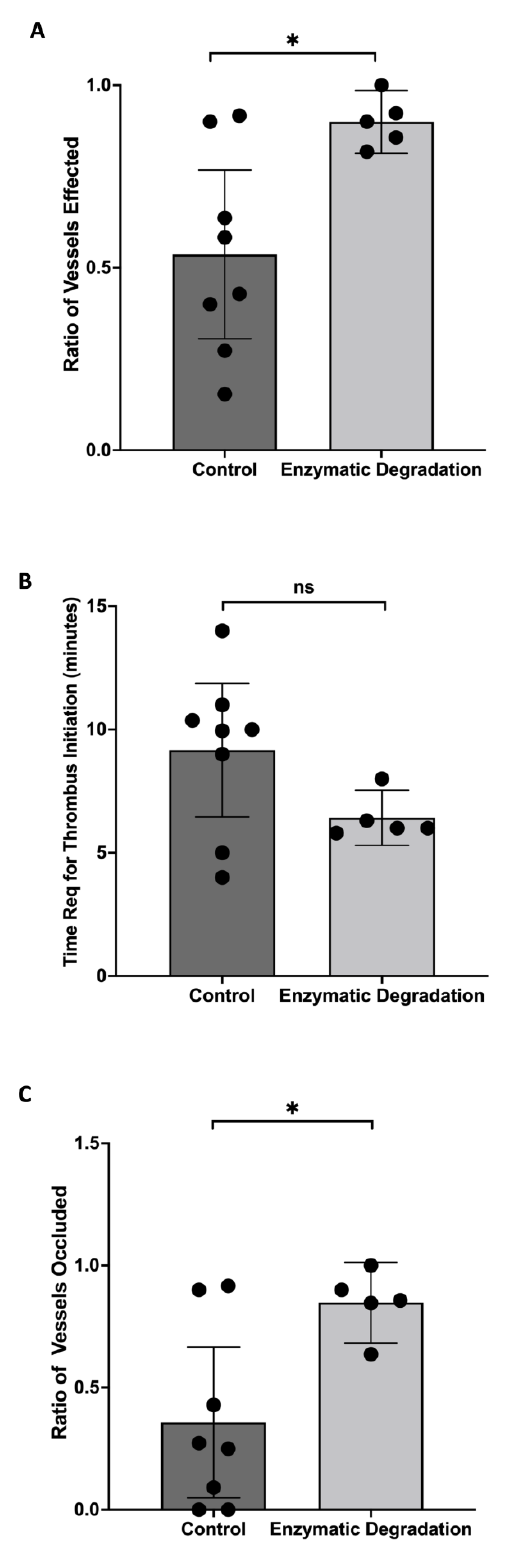
Figure 7. Effect of Endothelial Glycocalyx Degradation on Thrombosis Induction. Quantification of the thrombosis assay. ( A ) Ratio of vessels exhibiting thrombus formation, ( B ) average time required for initiation of thrombus formation, and ( C ) ratio of vessels in which flow was completely stopped due to thrombus formation in control mice (n = 8) and mice infused with hyaluronidase and heparinase (n = 5); means with 95% confidence intervals. * p < 0.05 and ns = nonsignificant.